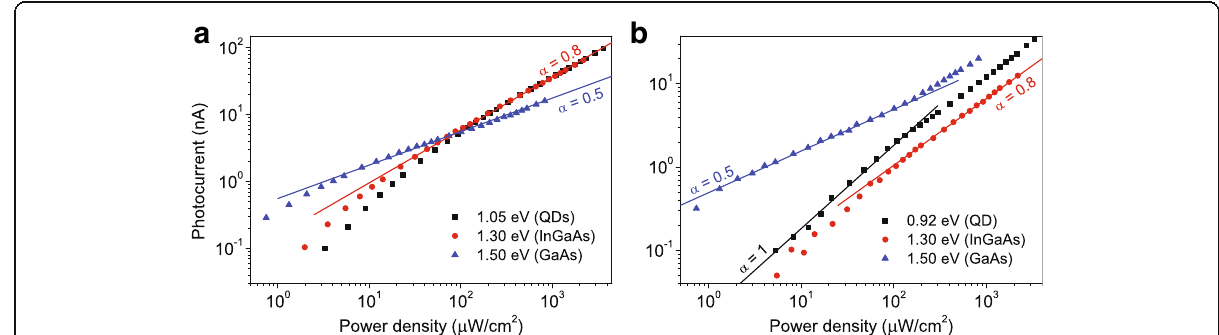
Fig. 5 Color online. Photocurrent vs excitation intensity for the InAs/In x Ga 1 − x As structures with a x = 0.15 and b 0.31. The lines are the fitting by functions f ( x ) ~ x